Question: Identify the chart type used in this figure.
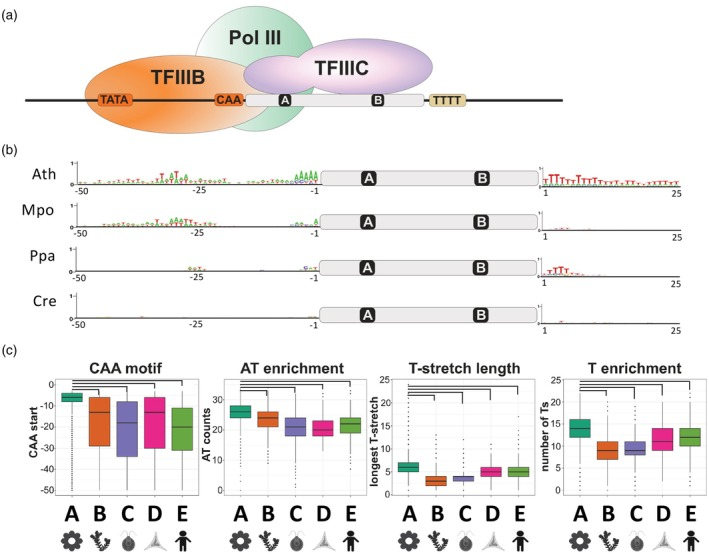
Answer: box